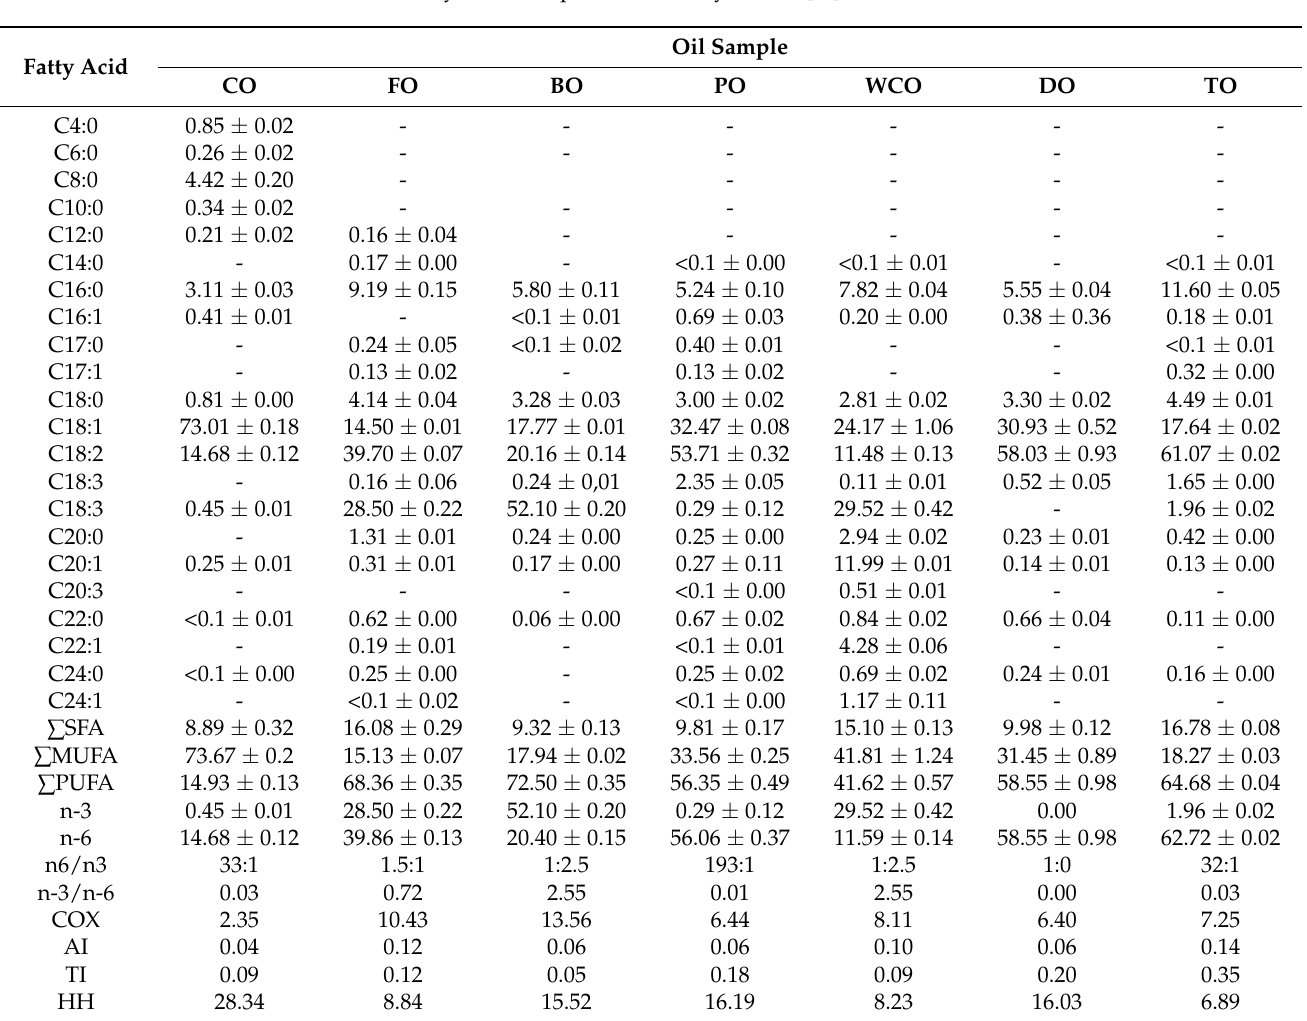
Table 3. Fatty acids composition of analysed oils